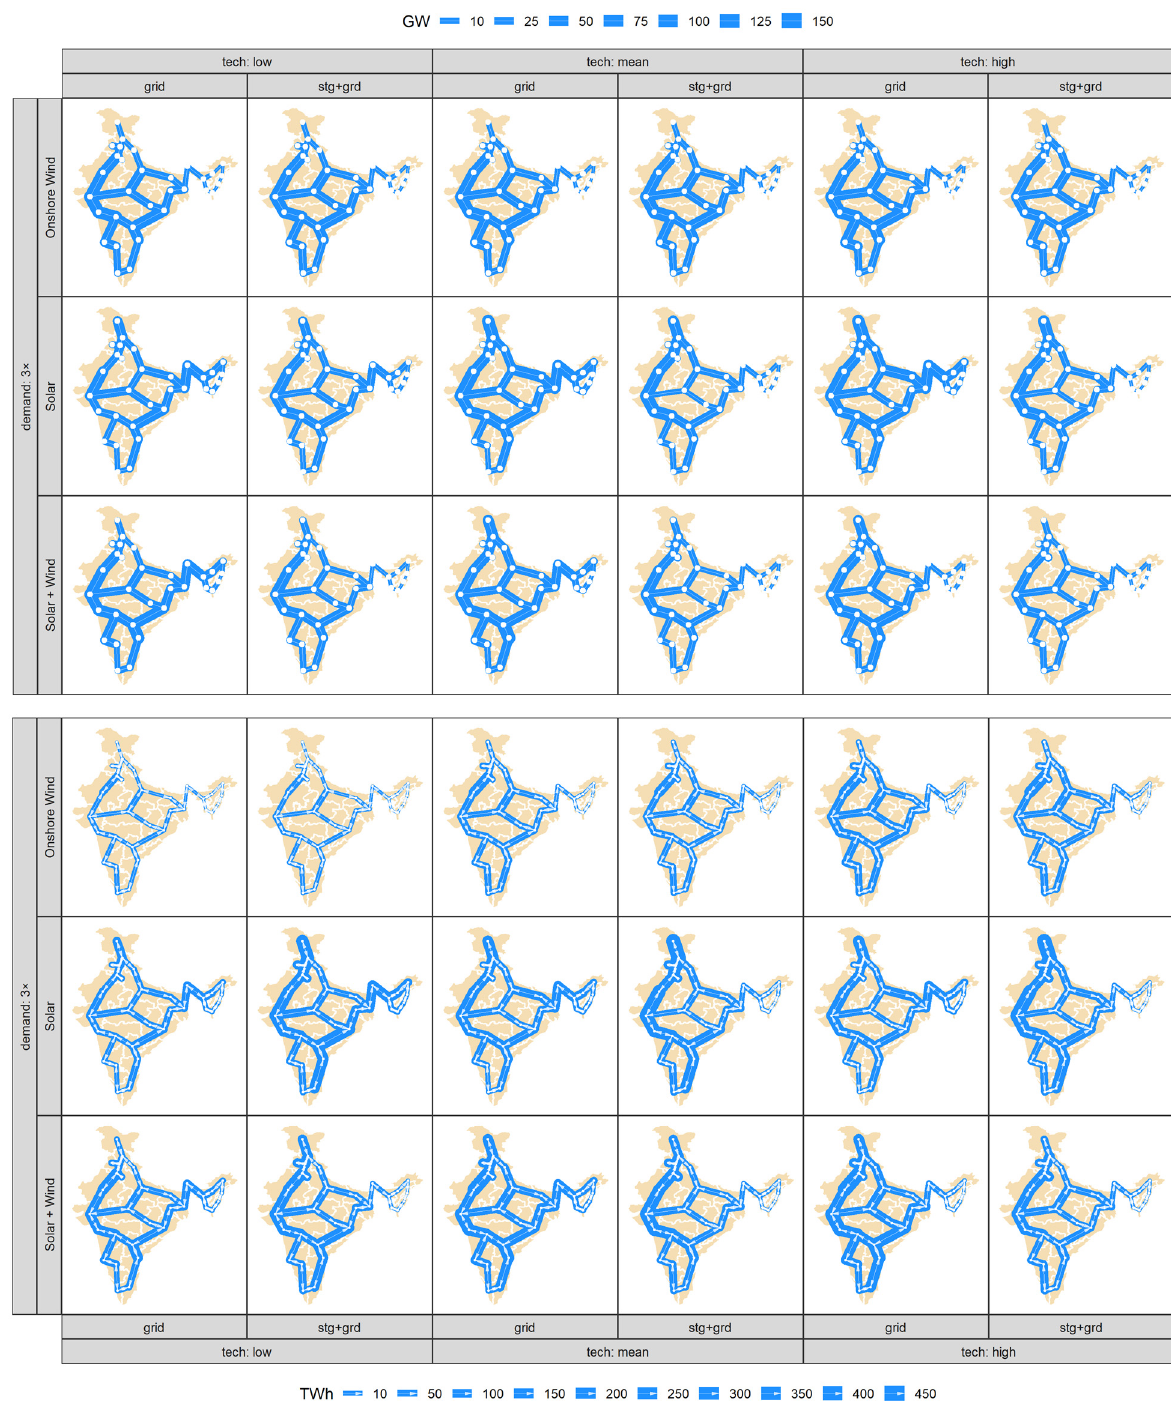
Figure A27. Interregional grid capacity and annual trades by scenario, demand level triple that of 2019.